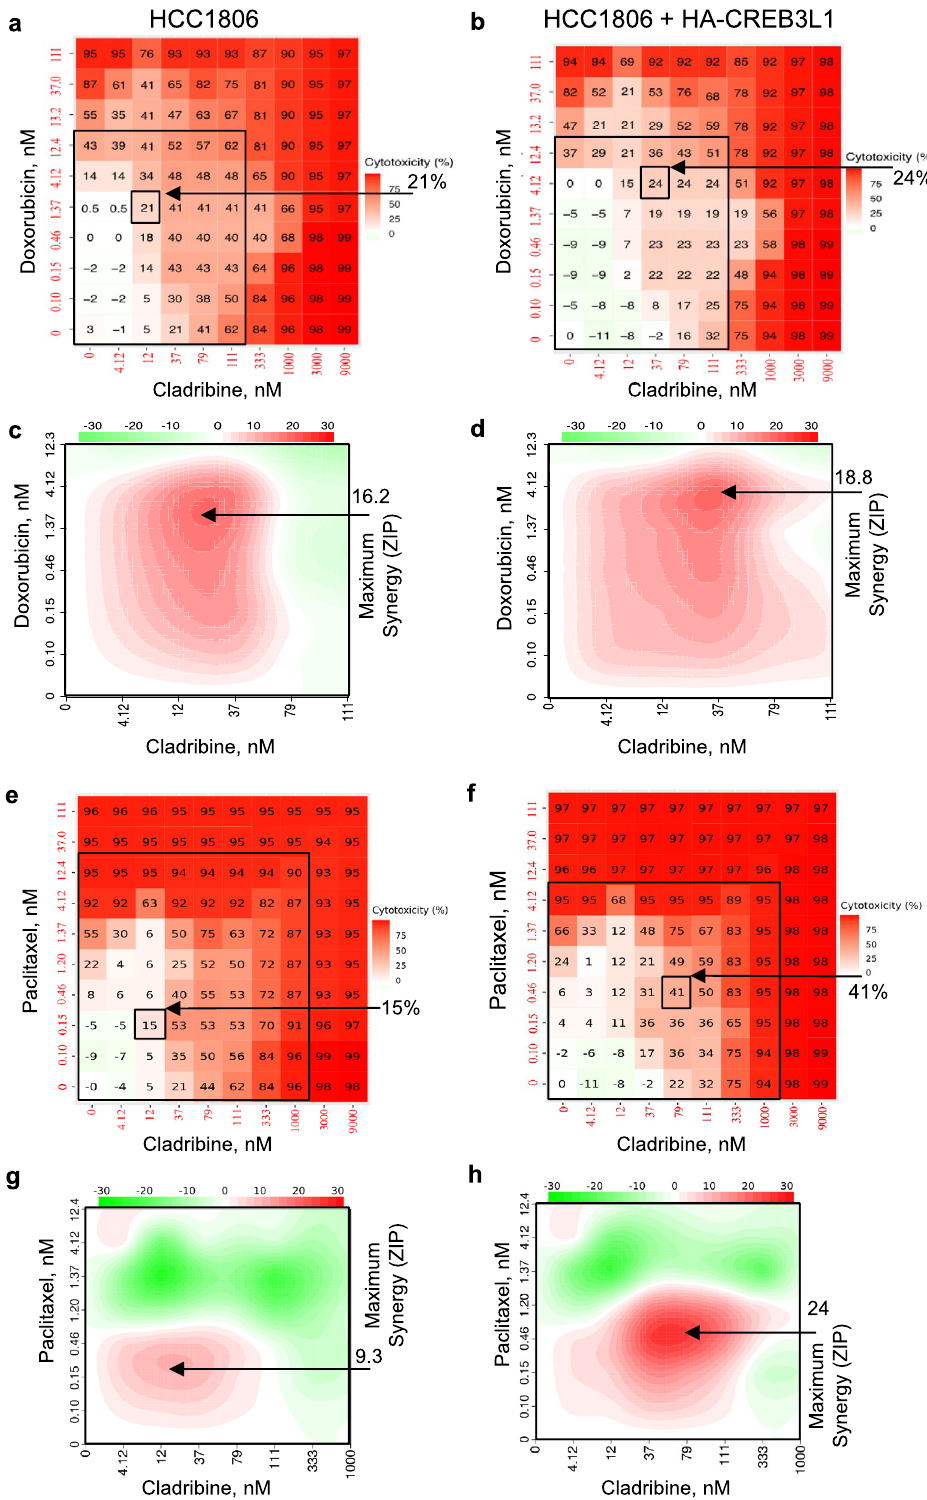
Figure 5. Assessing possible drug synergy between cladribine and either doxorubicin ( a-d ) or paclitaxel ( e–h ). Cell viability ( a, b, e, f ) was measured after 4 days of drug treatment over a range of drug concentrations for HCC1806 ( a, c, e, g ) and HCC1806 + HA-CREB3L1 ( b, d, f, h ) cells. Cladribine EC 50 for HCC1806 = 92 nM; 1:3 serial dilutions (0–9 mM). Doxorubicin EC 50 for HCC1806 = 13 nM; 1:3 serial dilutions (0–111 nM). Paclitaxel EC 50 for HCC1806 = 1.2 nM; 1:3 serial dilutions (0–111 nM). A zero-interaction potency score (ZIP; c, d, g, h ) was calculated by the SynergyFinder R-package for each data point to measure possible drug synergy; ZIP > 10 indicates